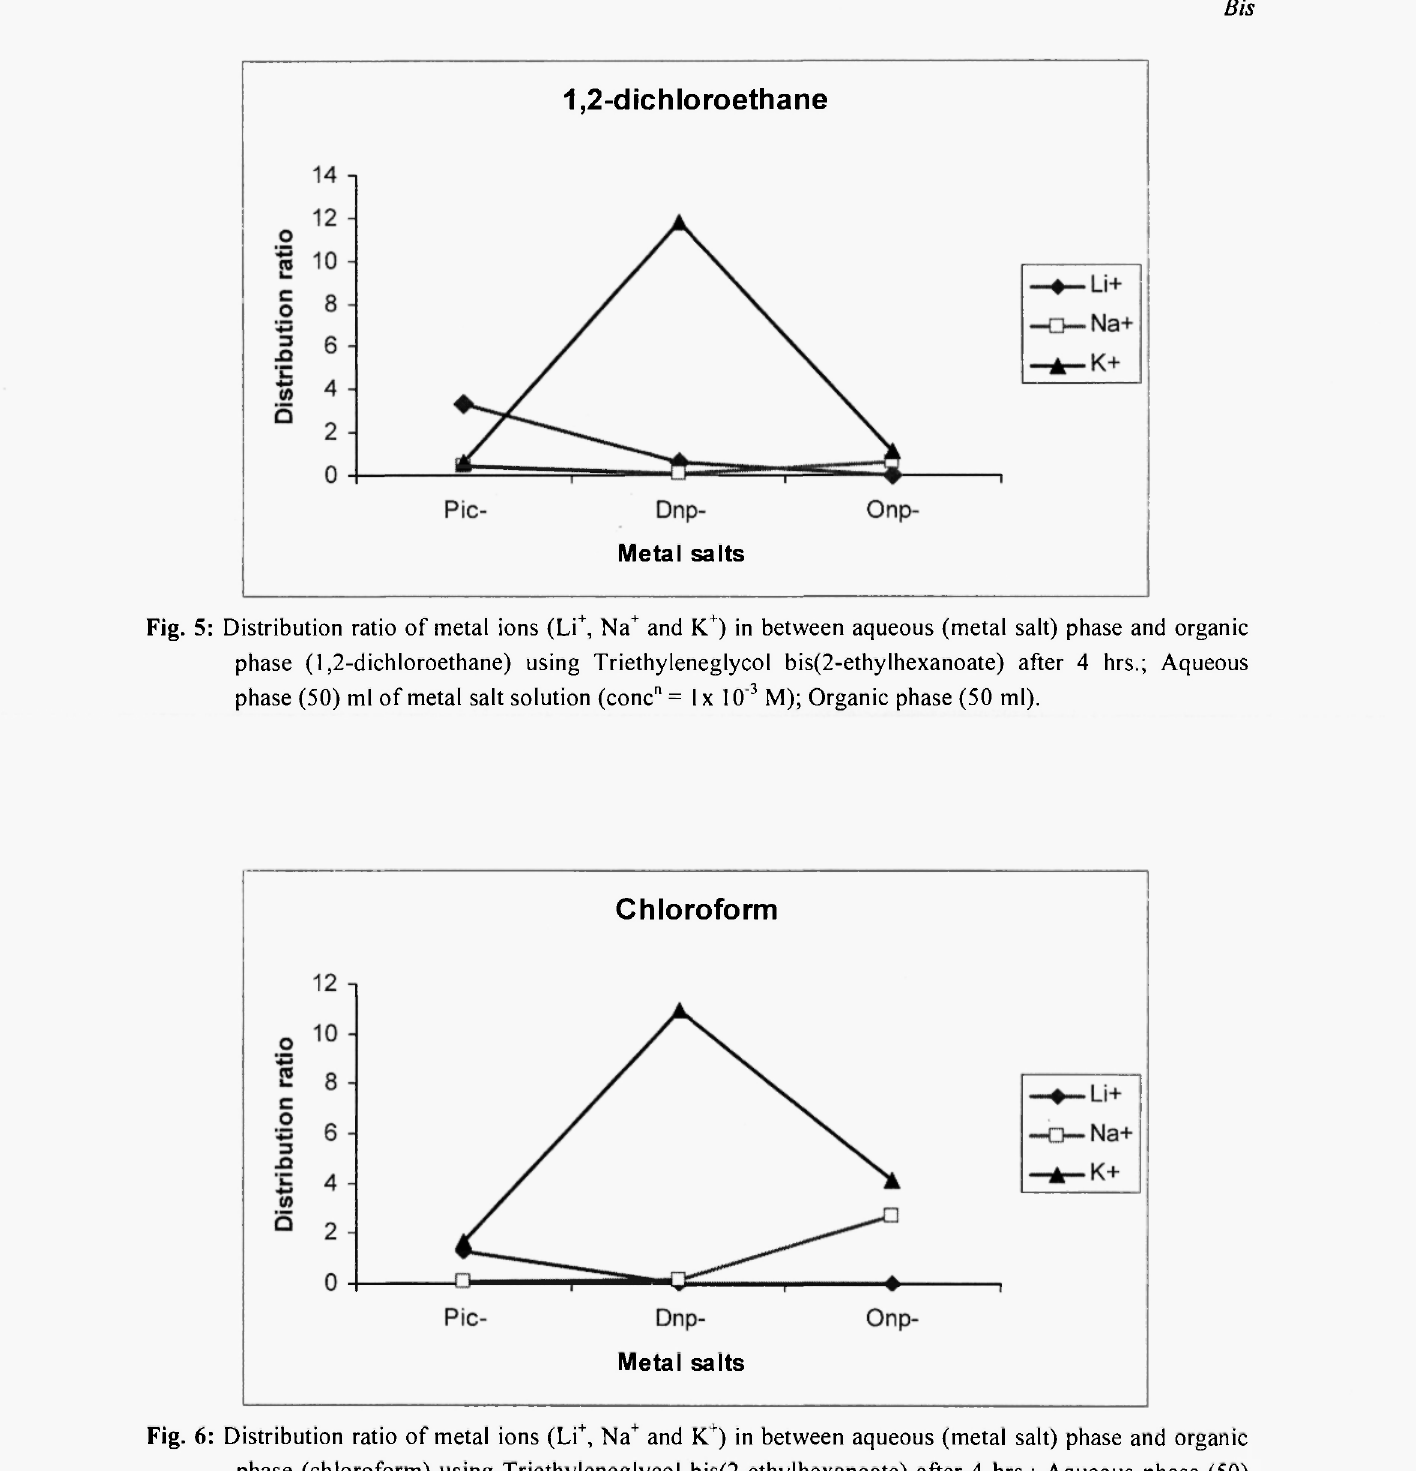
Fig. 6: Distribution ratio of metal ions (Li + , Na + and K + ) in between aqueous (metal salt) phase and organic phase (chloroform) using Triethyleneglycol bis(2-ethylhexanoate) after 4 hrs.; Aqueous phase